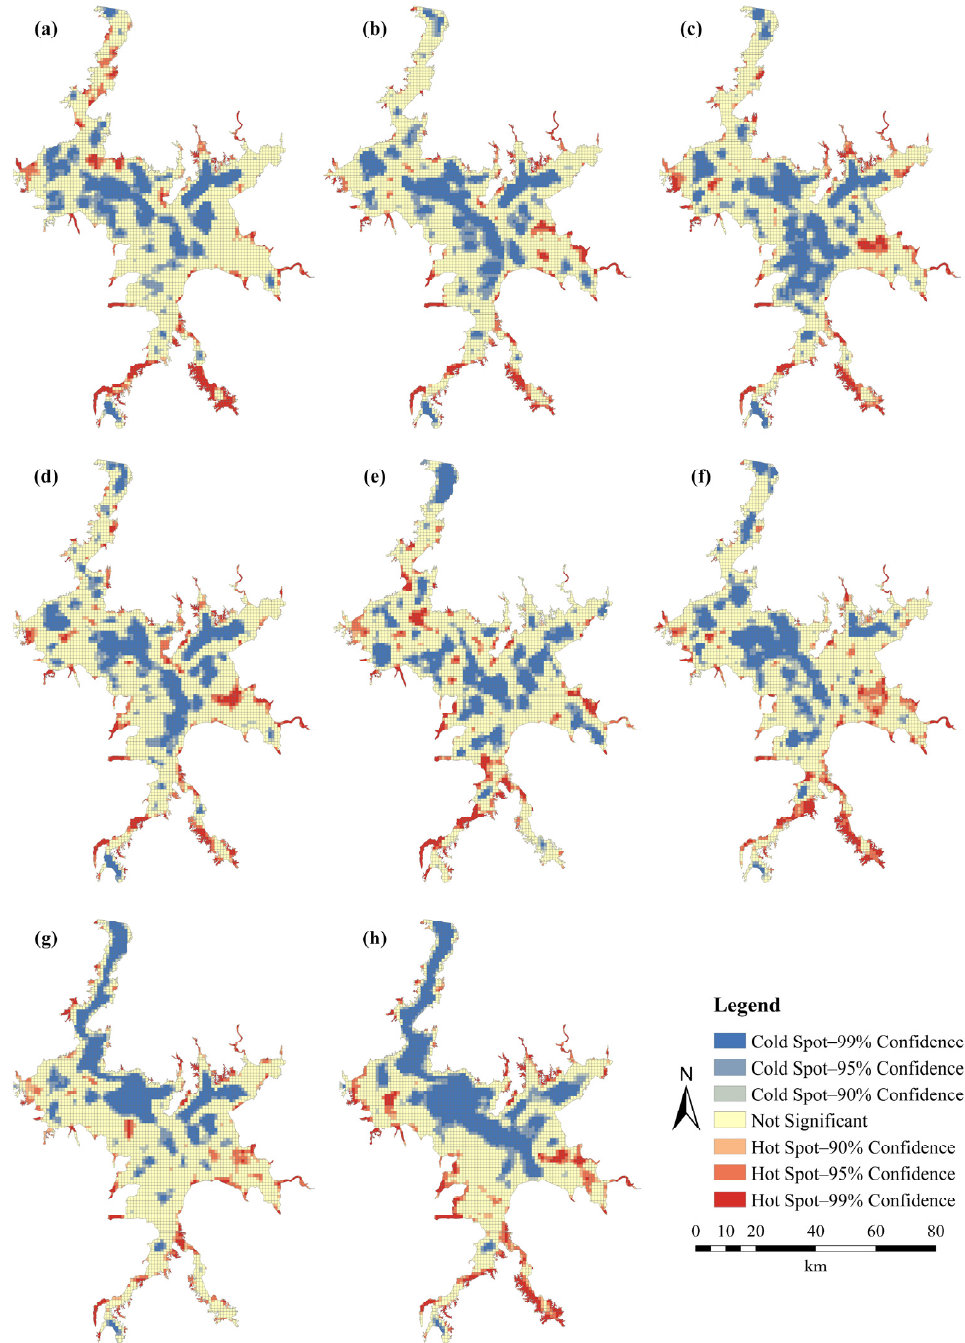
Figure 9. Hot and cold spots of the varieties of crane habitats within various water level intervals: ( a ) 5–6 m; ( b ) 6–7 m; ( c ) 7–8 m; ( d ) 8–9 m; ( e ) 9–10 m; ( f ) 10–11 m; ( g ) 11–12 m; ( h ) 12–16 m.